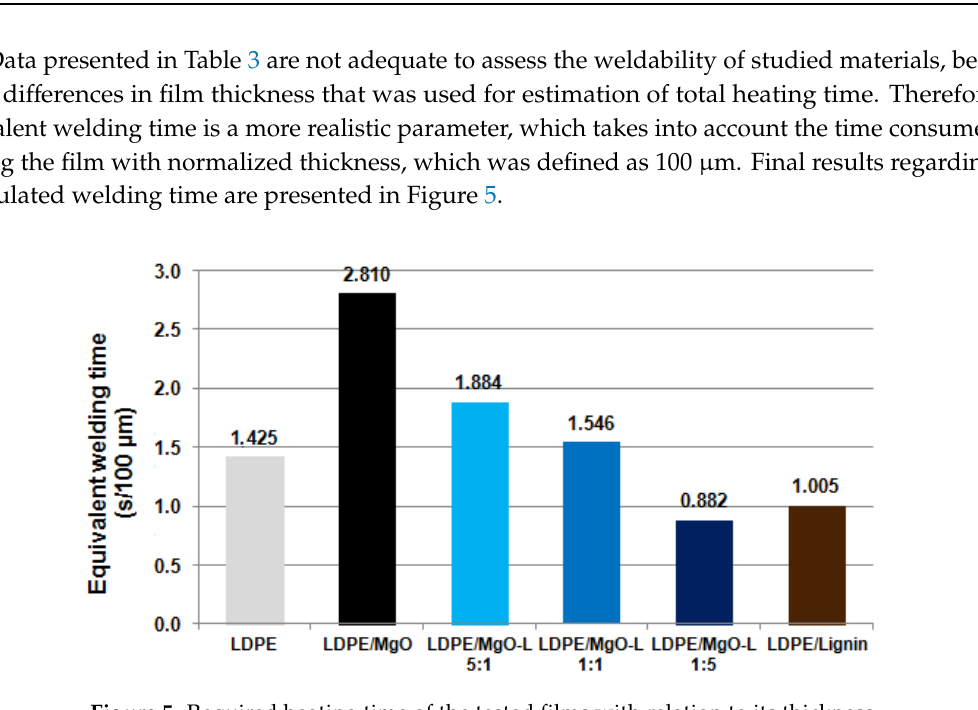
Table 3. Welding conditions applied to achieve welded joint of extruded films.